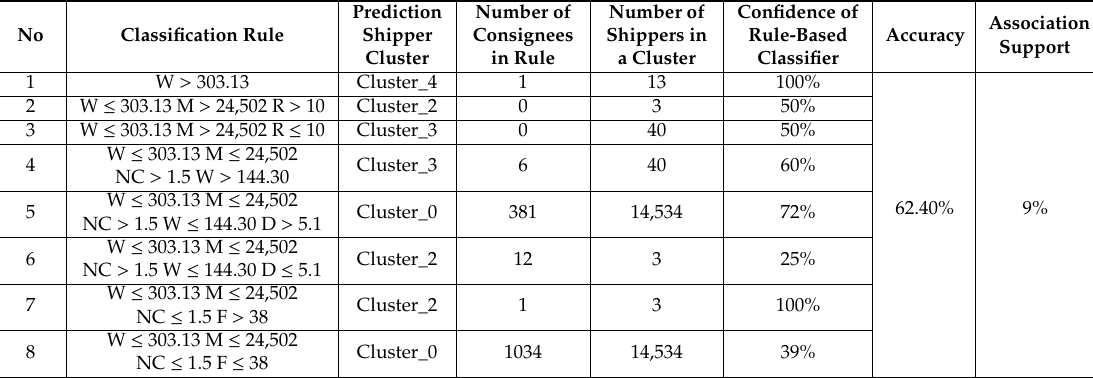
Table 7. Classification rules extracted through the decision tree model.